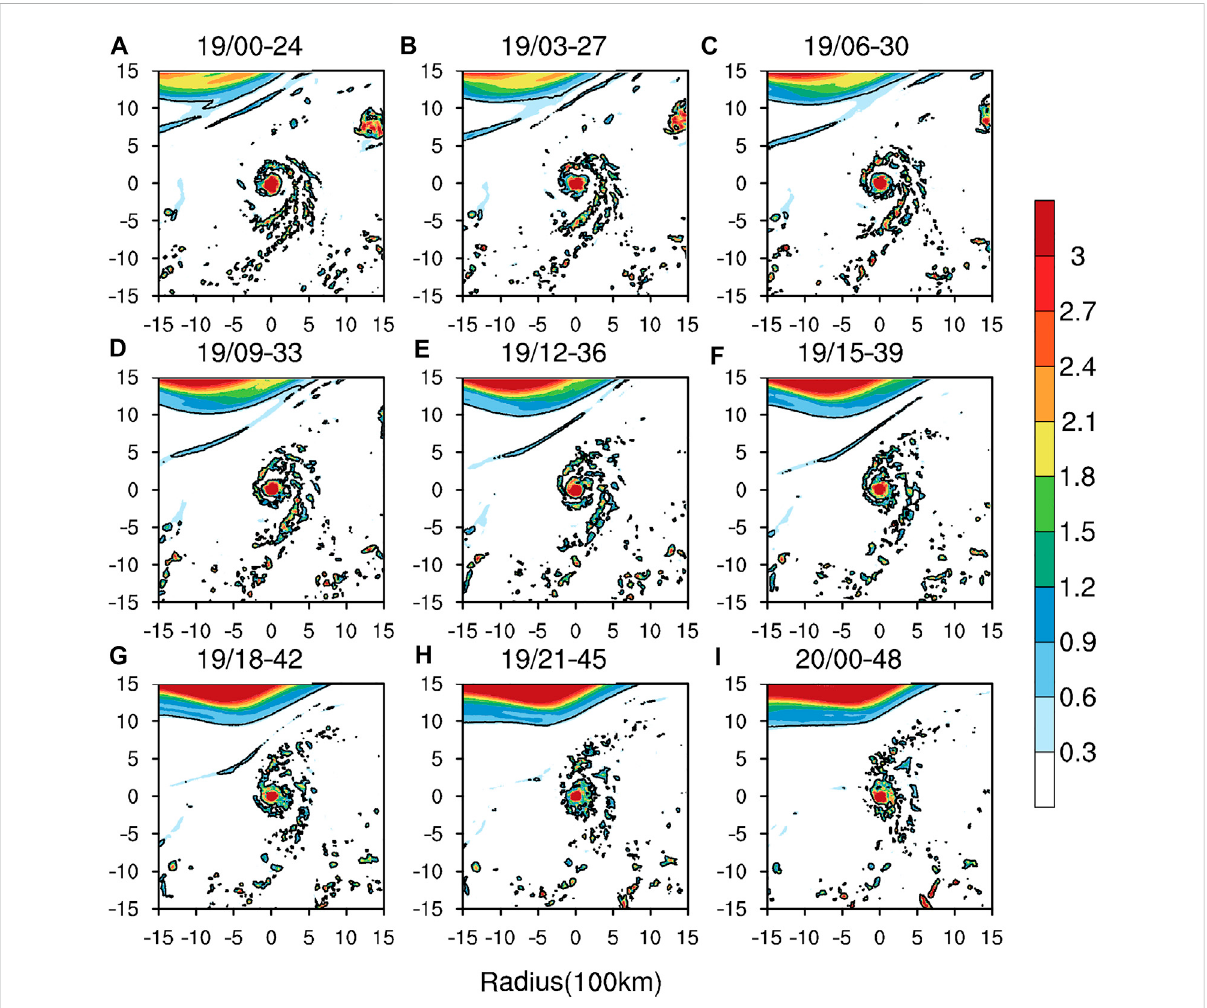
FIGURE 10 The 3-h potential vorticity anomaly (PVU) at the 350-K isentropic surface from 0000 UTC 19 September (24-h integration) to 0000 UTC 20 September (48-h integration). The contour represents the potential vorticity anomaly of 0.3